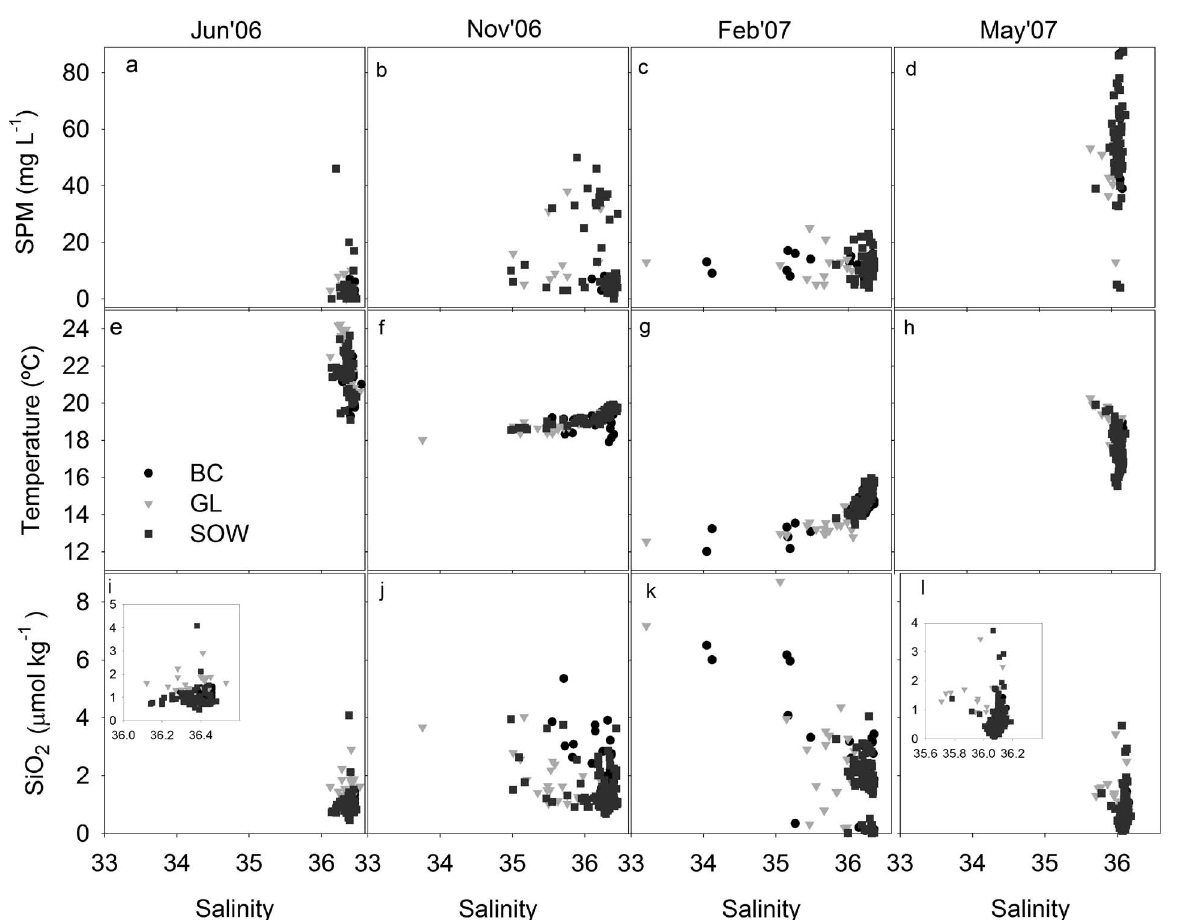
Fig. 3. – Mixing diagrams of suspended particulate matter (mg L –1 ), temperature (°C) and silicate (µmol kg –1 ). The inset plots in i and l are a zoom of the main figures. Data are divided into three sectors: Bay of Cádiz (black circles), Guadalquivir Estuary (gray triangles) and surface oceanic water (gray